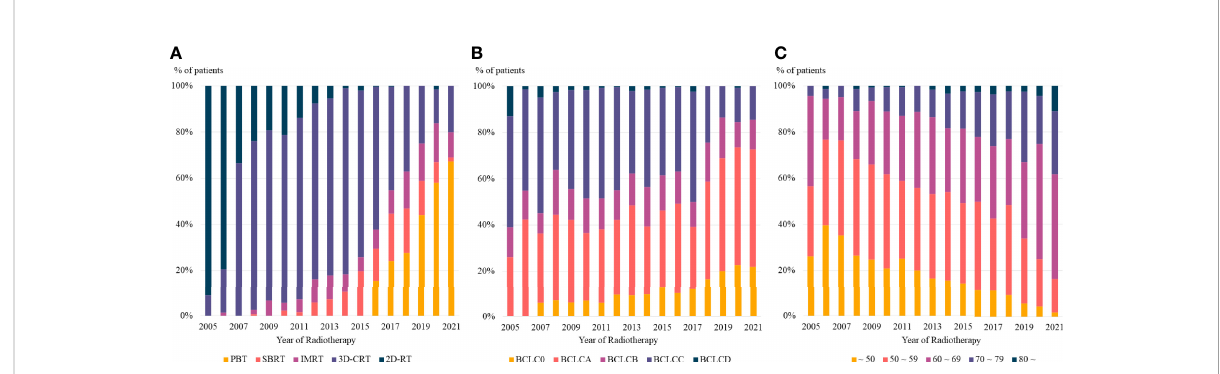
FIGURE 3 The trends in (A) radiotherapy delivery technique, (B) BCLC stage, and (C) age at radiotherapy based on the year of radiotherapy. PBT, proton beam therapy; SBRT, stereotactic body radiotherapy; IMRT, intensity modulated radiotherapy; 3D-CRT, three dimensional conformal radiotherapy, 2D-RT, two dimensional radiotherapy; BCLC, Barcelona Clinic Liver Cancer.